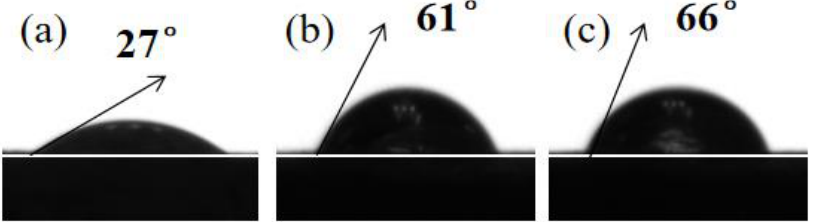
Figure 7. Contact angle pictures for the specimen exposed to SCP with and without 0.12 mM PMD and SPMD: ( a ) SCP; ( b ) SCP+0.12 mM PMD; ( c ) SCP +0.12 mM SPMD.